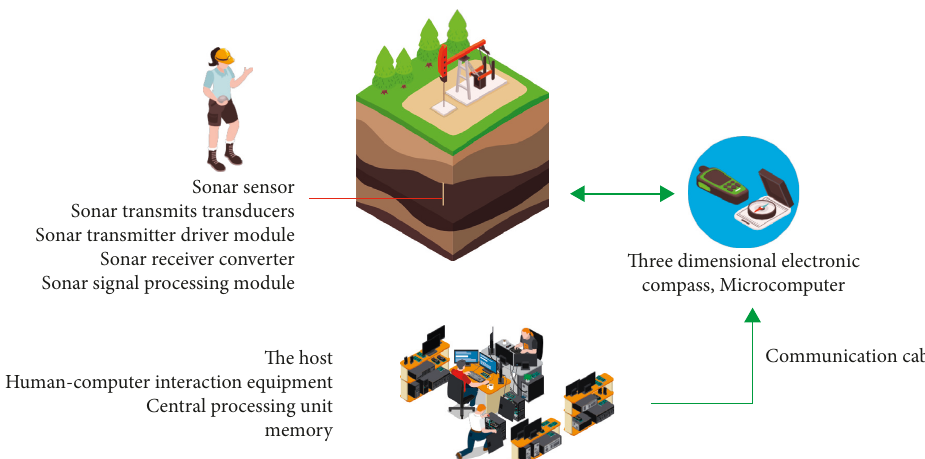
Figure 5: Structure block diagram of a sonar detector for the karst cave at the bottom of